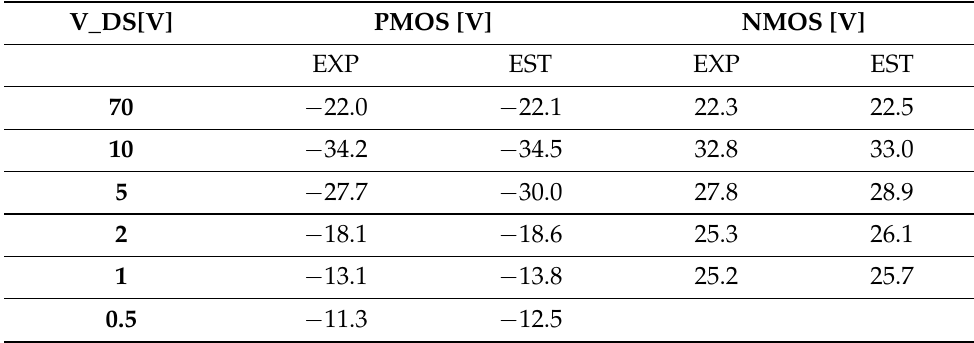
Table 4. Comparison between PMOS and NMOS